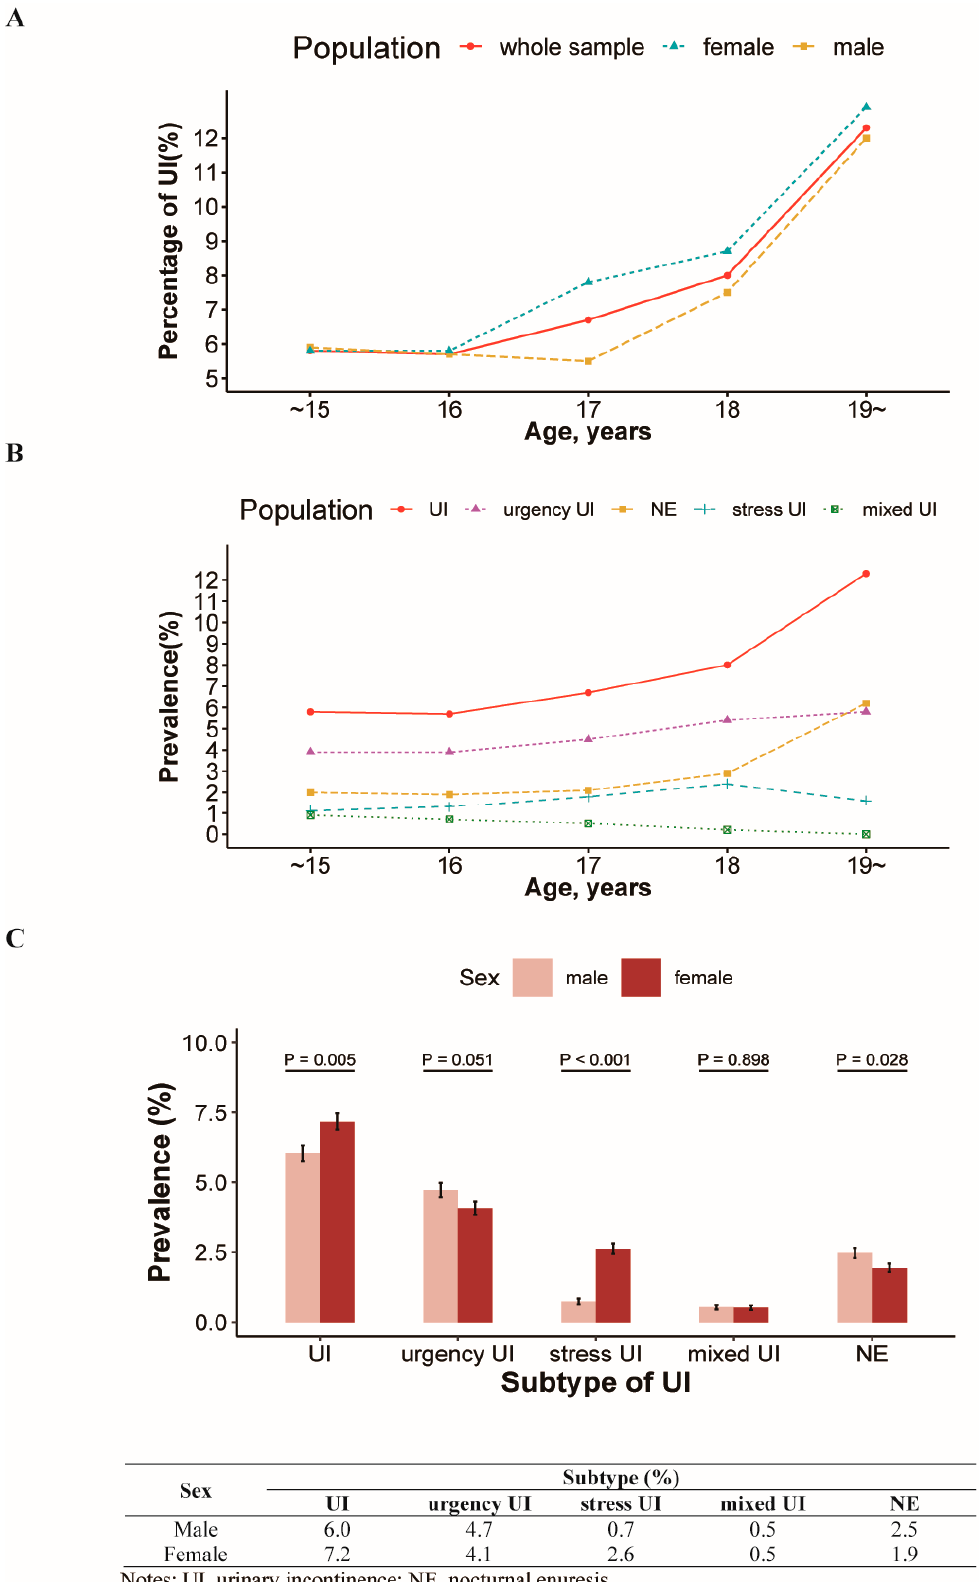
Figure 2. The prevalence of UI and UI subtype by age group and sex. ( A ) Prevalence of UI by age group; ( B ) Prevalence of UI subtype by age group; ( C ) Prevalence of UI subtype by sex.